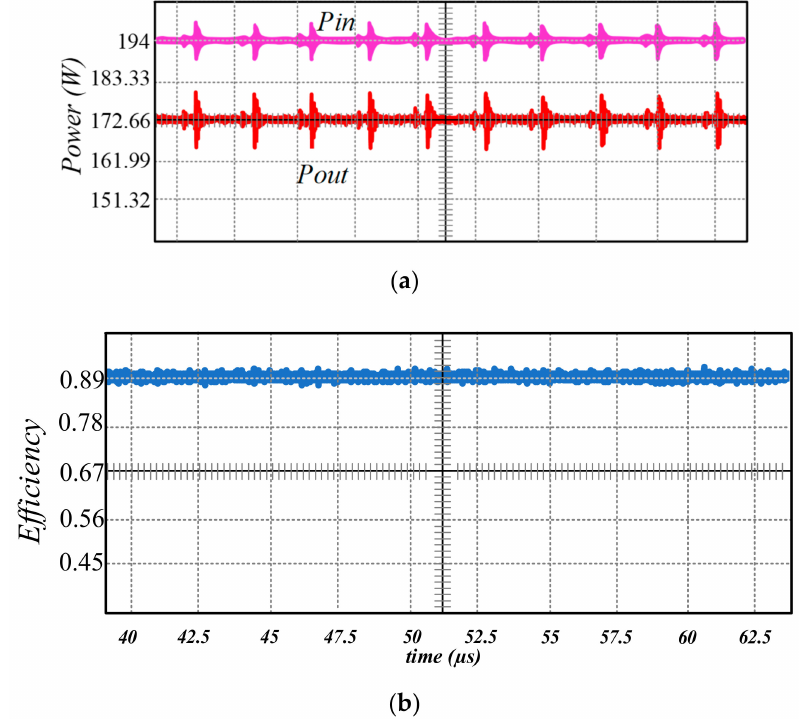
Figure 15. Electrical signals of the third array ( a ) input and output power, ( b ) e ffi ciency